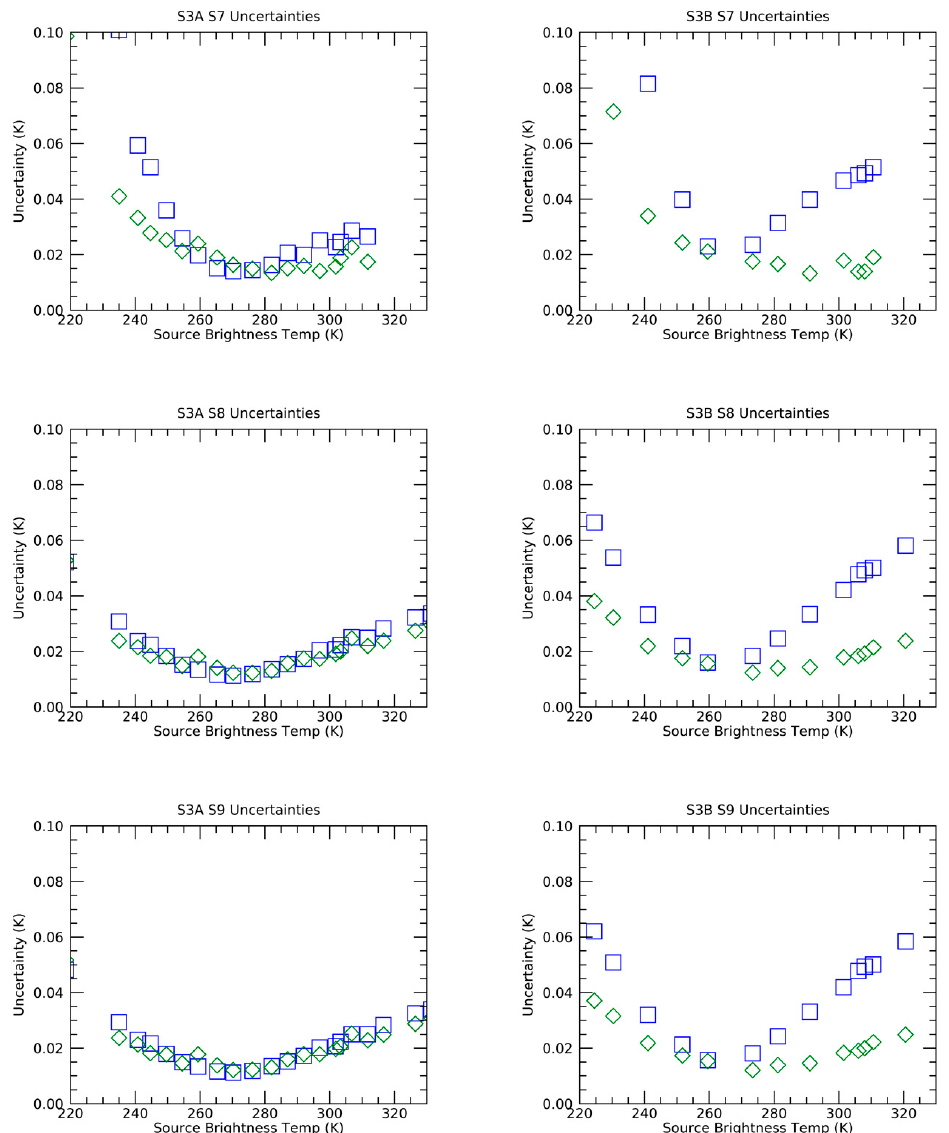
Figure 3. Uncertainty estimates at k = 1 for SLSTR-A and SLSTR-B calibration tests. Green diamonds, = uncertainties in the reference brightness temperatures derived from the external BB thermometers (cid:51) and emissivity. Blue squares, (cid:3) = uncertainties in the SLSTR measurements derived from the instrument calibration